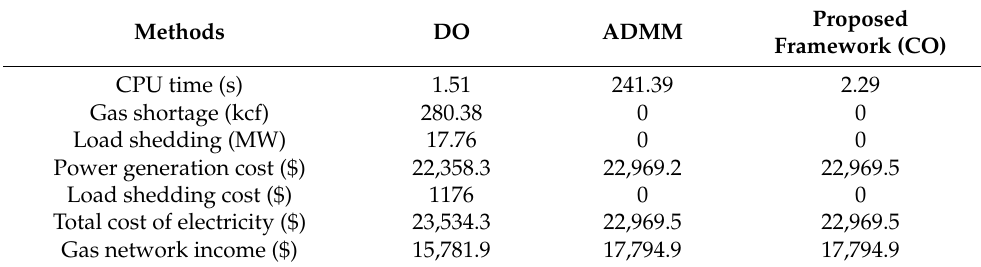
Table 3. Performance